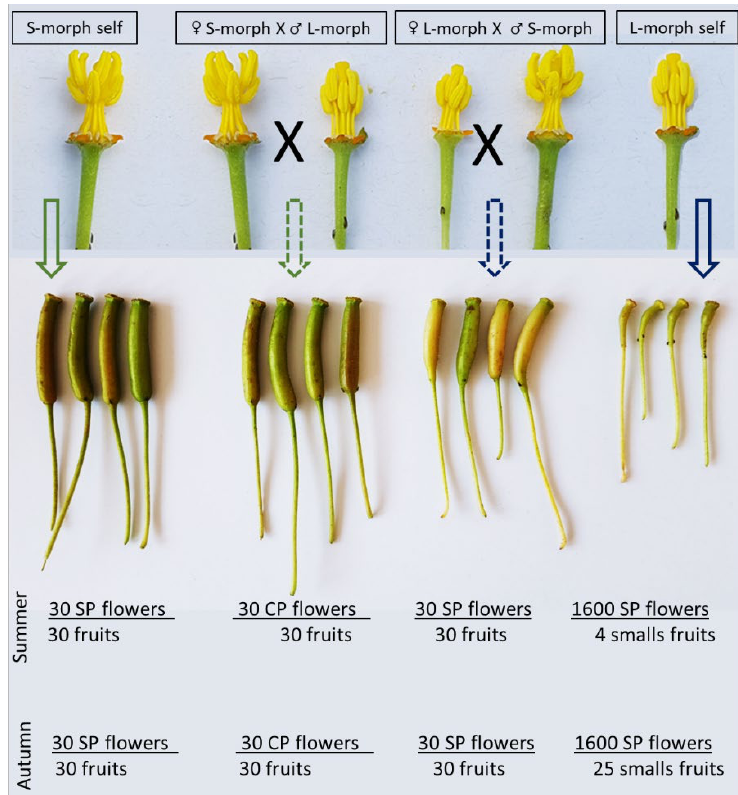
Figure 6: Summary of the fruit-set obtained from S-morph and L-morph flowers after hand-controlled pollination (SP = Self-pollination; CP = Cross-pollination) in summer and autumn. All S-morph flowers produced fully-seeded fruits, in summer and autumn, both after self- and cross-pollinations. All L-morph flowers produced fully-seeded fruits, in summer and autumn, when pollinated with S-morph pollen (L- morph x S-morph). 0.25% and 1.56% of L-morph flowers produced “small fruits” in summer and autumn when self-pollinated. These “small fruits” contained one to nine seeds that all successfully germinated and grew into viable